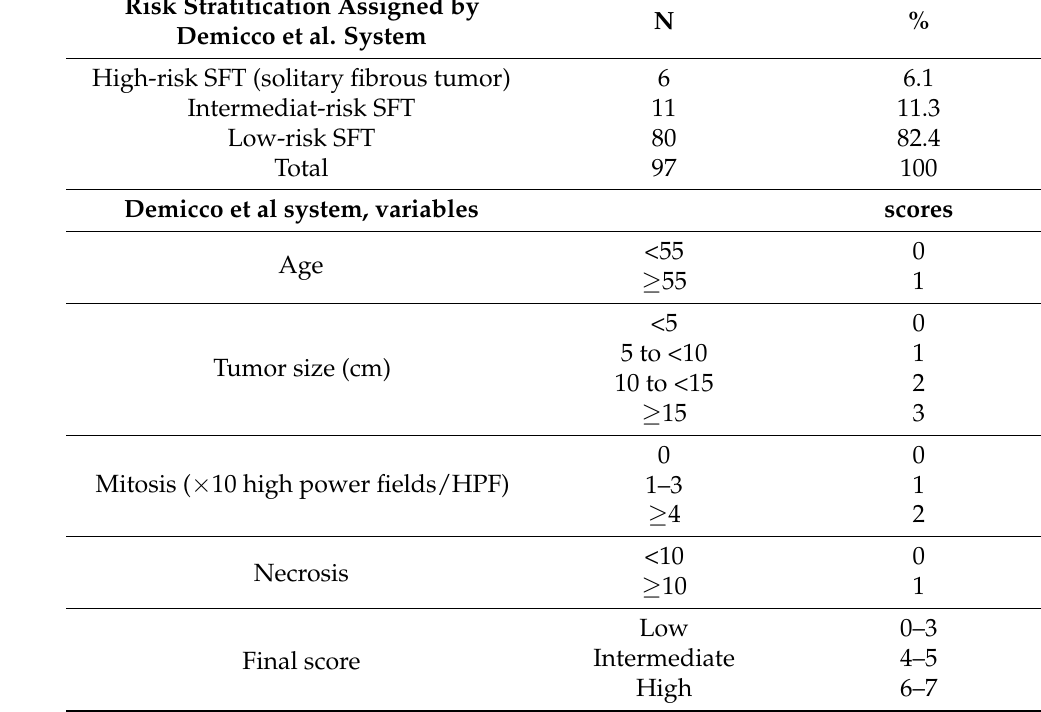
Table 6. Solitary fibrous tumor. Risk stratification system results and Demicco et al. system (N = 97).